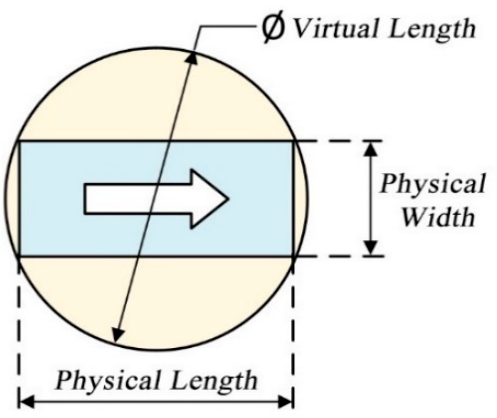
Figure 6. Diagram of virtual length and physical width.